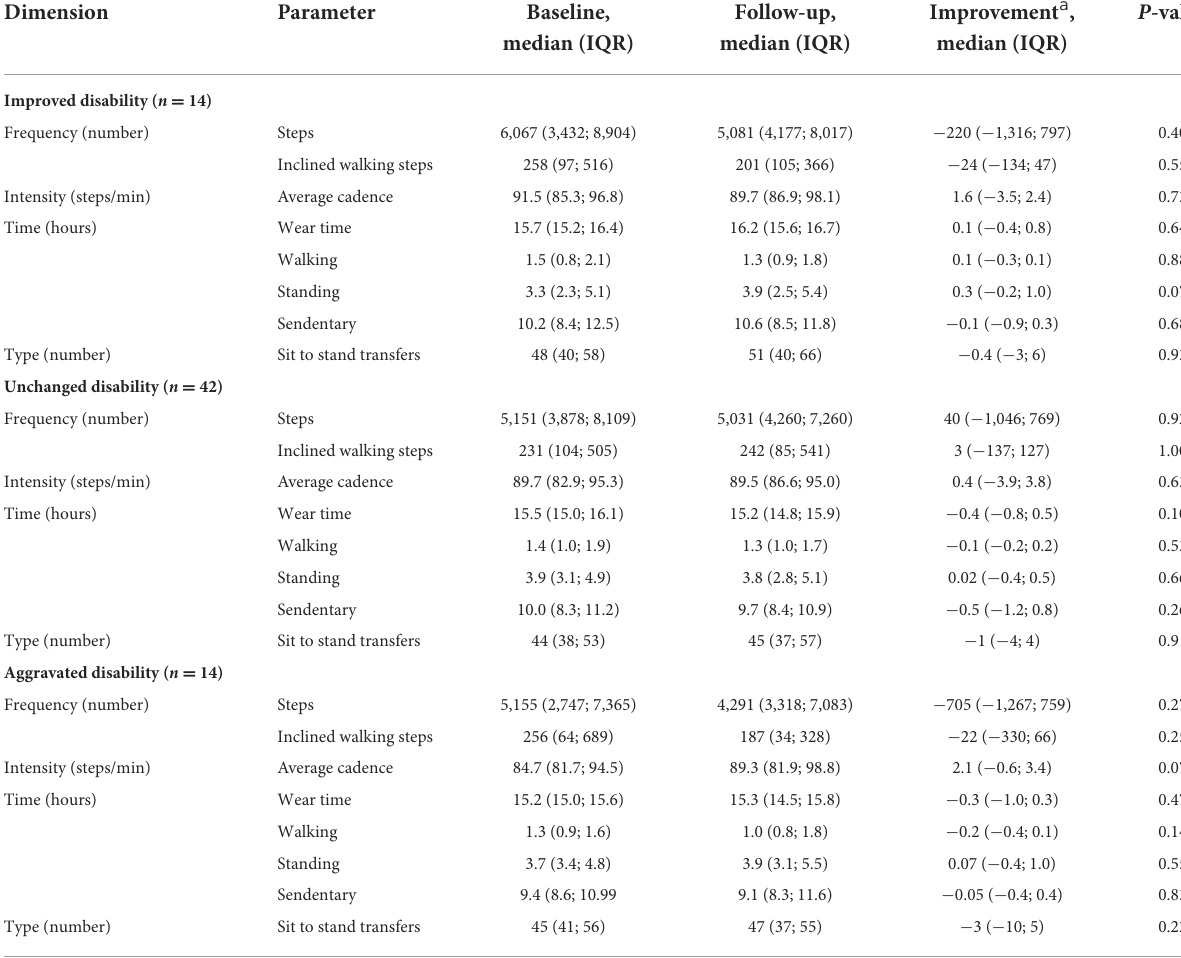
TABLE 4 Physical activity per day in relation to the change in disability described by the dimensions of frequency, intensity, time, and type. Dimension